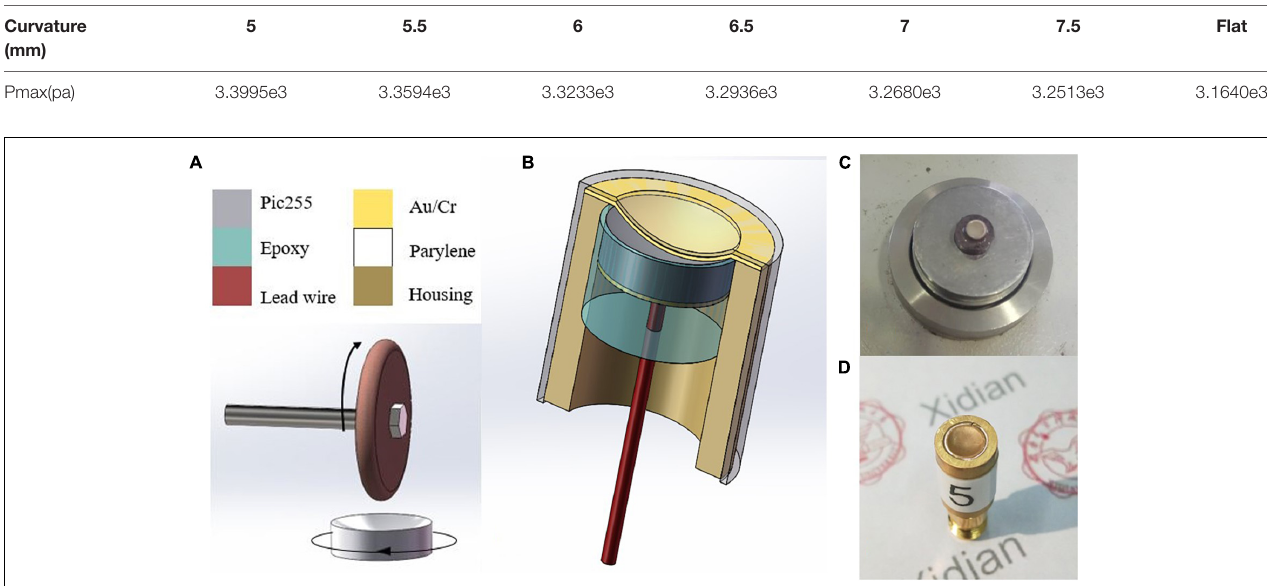
TABLE 2 | Maximum acoustic pressure.